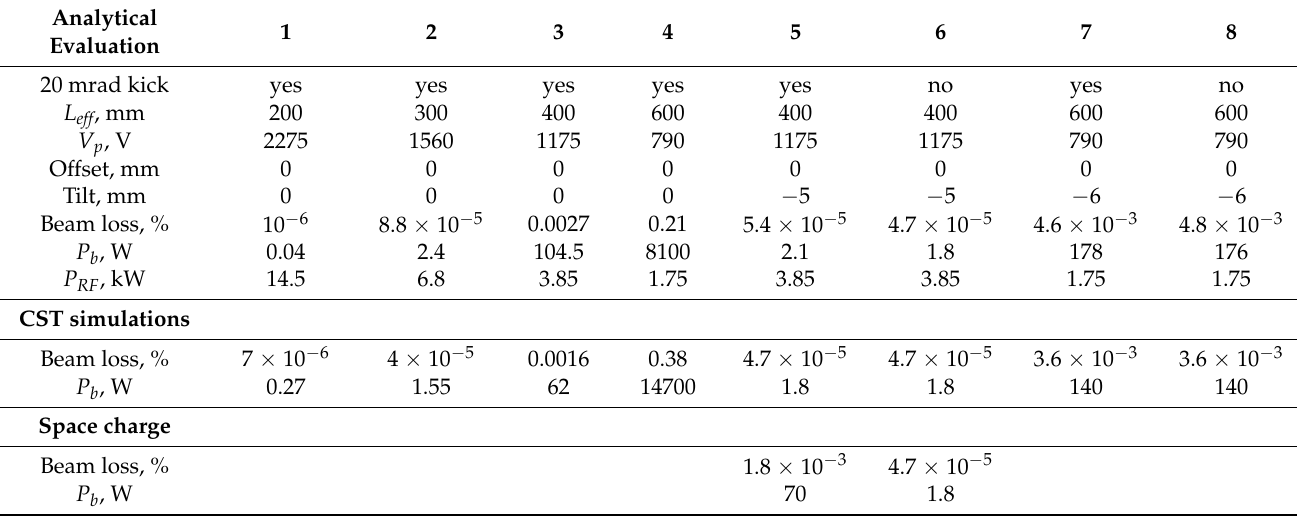
Table 2. The beam loss with various strip line lengths.